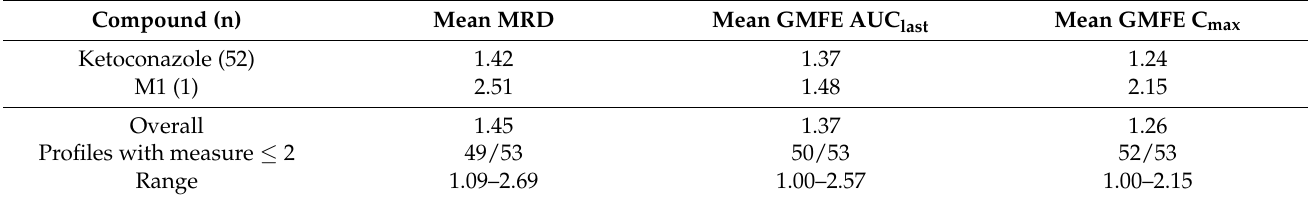
Table 2. Summary of quantitative measures of model performance for ketoconazole and its metabolite M1.